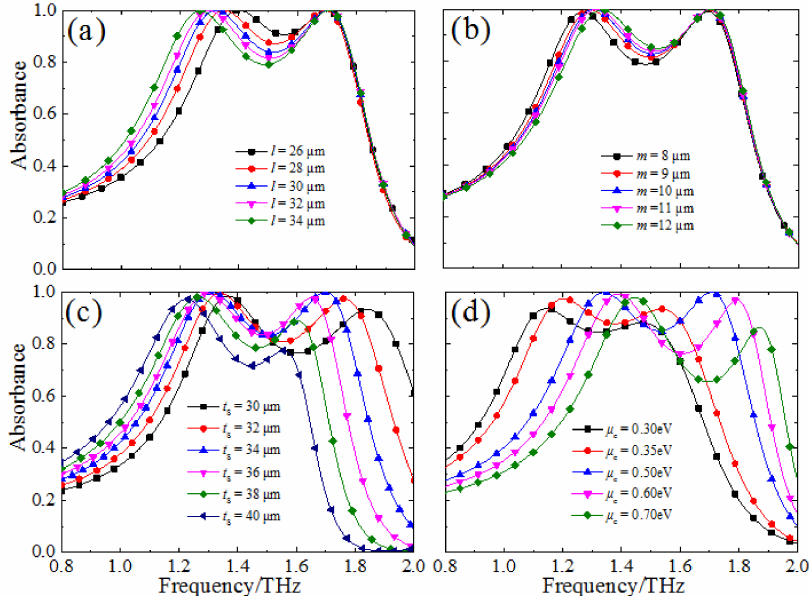
Figure 6. The absorption spectra under different geometric parameters of the unit-cell structure and chemical potential: ( a , b ) the long ( l ) and short ( m ) radius of the CCOSG structure; ( c ) the thickness ( t s ) of the dielectric substrate; ( d ) the chemical potential ( µ c